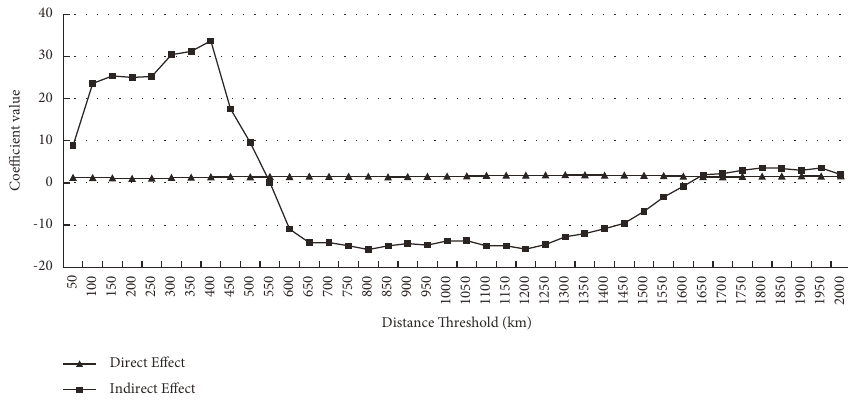
Figure 7: Spatial trends of the impact of the digital economy on urban innovation.